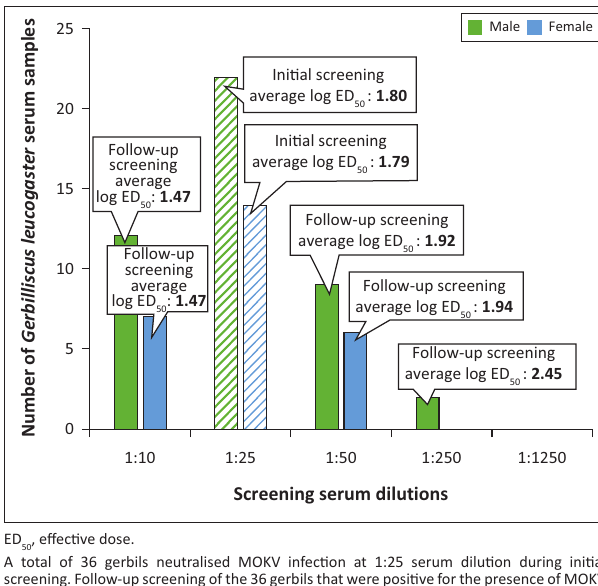
FIGURE 2: Graphical representation of the micro-neutralisation test results of the Gerbilliscus leucogaster serum samples from Meletse ( n = 36).